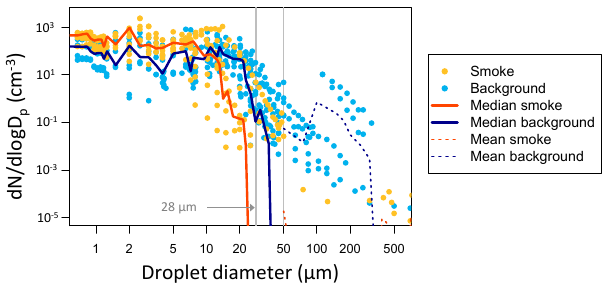
Figure 8. Mean cloud particle size distributions (µm) for all non- case study biomass burning clouds (yellow dots) and clean back- ground clouds (light blue dots). The 28 and 50µm lines are marked in gray. Thick red and darker blue lines indicate median values for binned size classes for smoky and clean clouds, respectively, in- cluding zero values not shown on the log–log plot. Due to the high number of zero values above > 50µm diameter, the mean values above this level are also shown (dashed lines) for